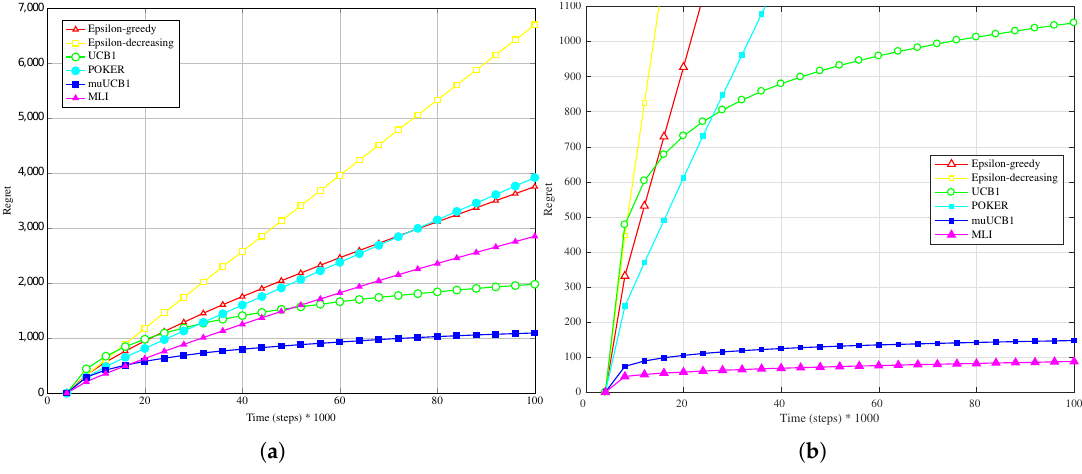
Figure 9. Performance in terms of regret of the six considered algorithms, with an exponential distribution for the reward PDF and T U / T M = 10. ( a ) Hard configuration; ( b ) Easy